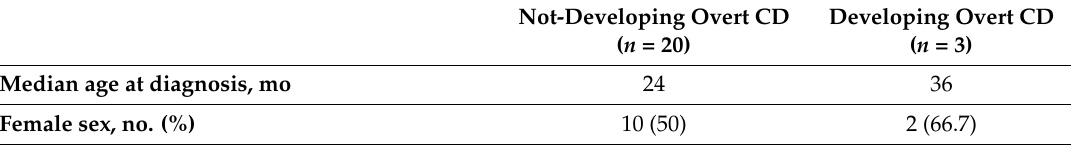
Table 1. Demographical, clinical, serological and genetic characteristics of children that developed overt celiac disease and children that remained potential.